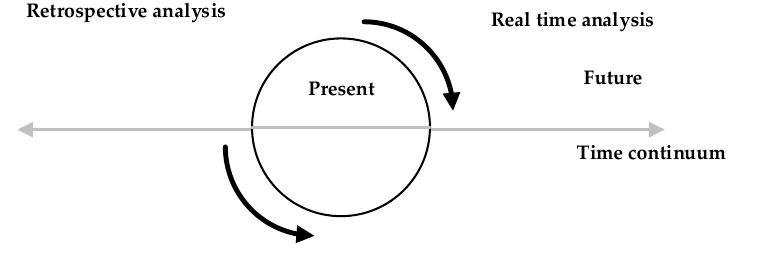
Figure 1. The method of identifying events.